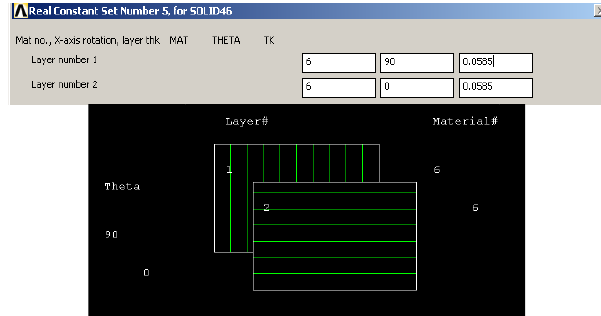
Figure 7. Model of FRP Layers